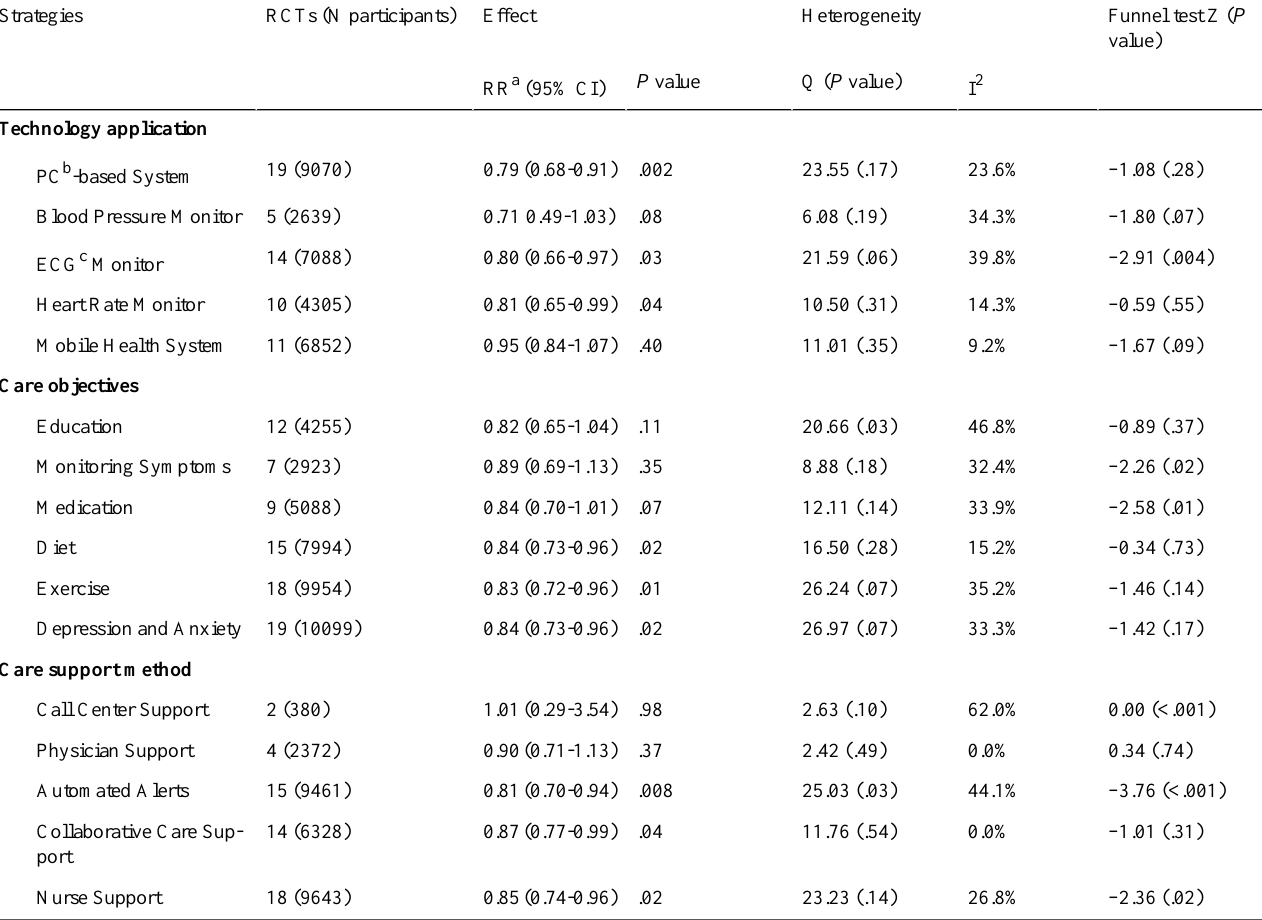
Table 8. Subgroup meta-analysis to examine the effect of telemonitoring strategies on mortality in randomized controlled trials (RCTs) that did not apply the strategy in the telemonitoring intervention (subgroup